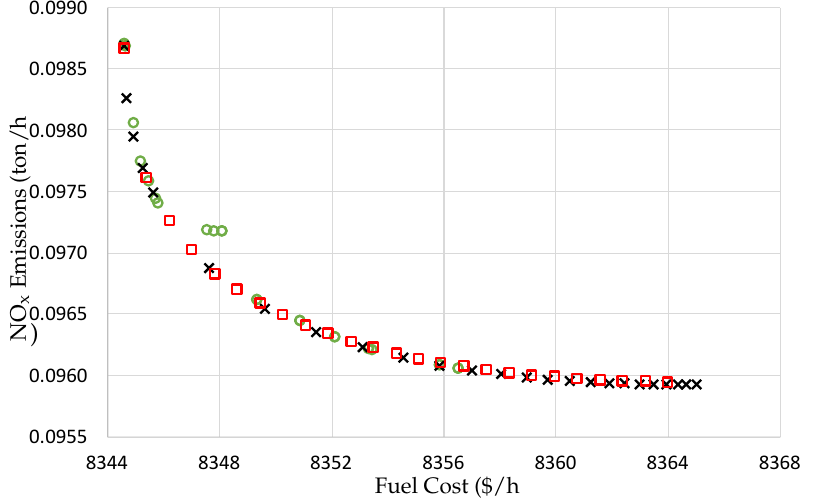
Figure 5. Pareto front for fuel cost and NO x emissions constructed using 25 elements. Red squares represent SQP, green circles represent NSGA-II , and black × represent